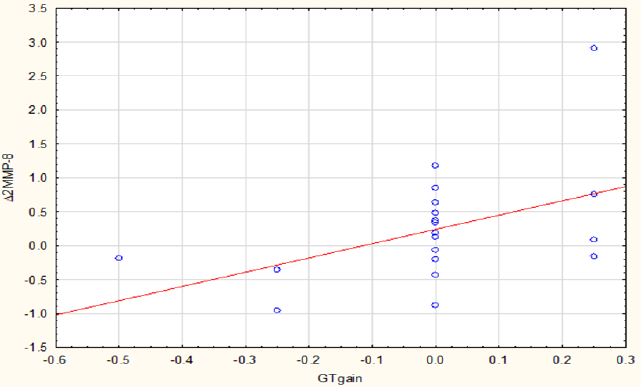
∆ 2MMP-8 (2W-0) and GTgain after Figure 5. Correlation between ∆ 2MMP-8 (2W- 0) and GTgain after CM. Figure 5. Correlation between